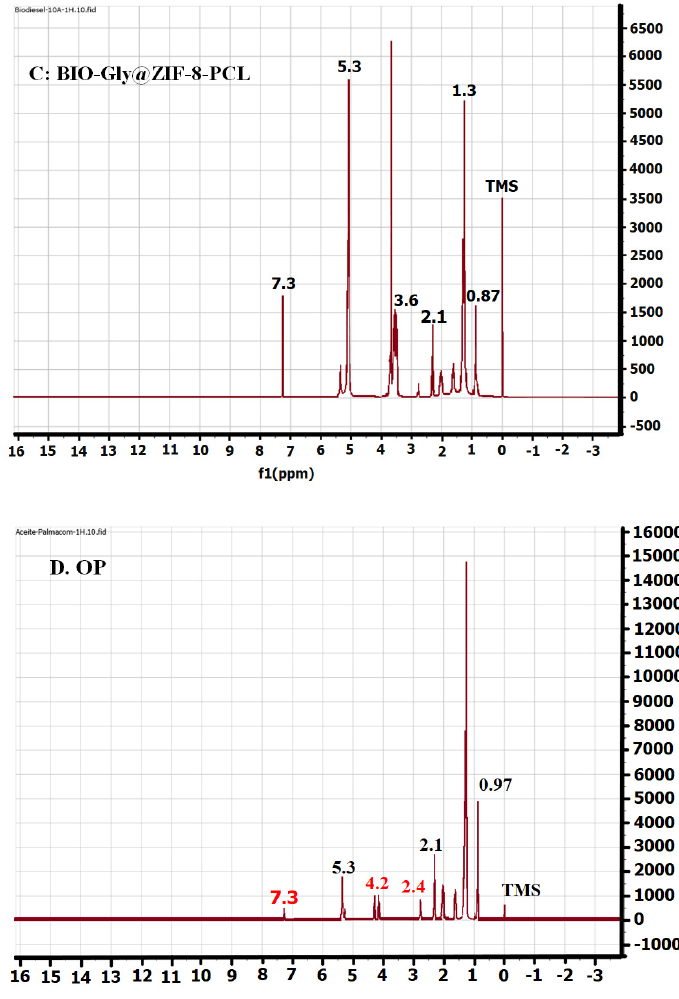
Figure 9. 1H NMR spectra of: ( A ) BIOC, ( B ) BIOZIF-8-PCL, ( C ) BIO-Gly@ZIF-8-PCL, and ( D ) palm oil.